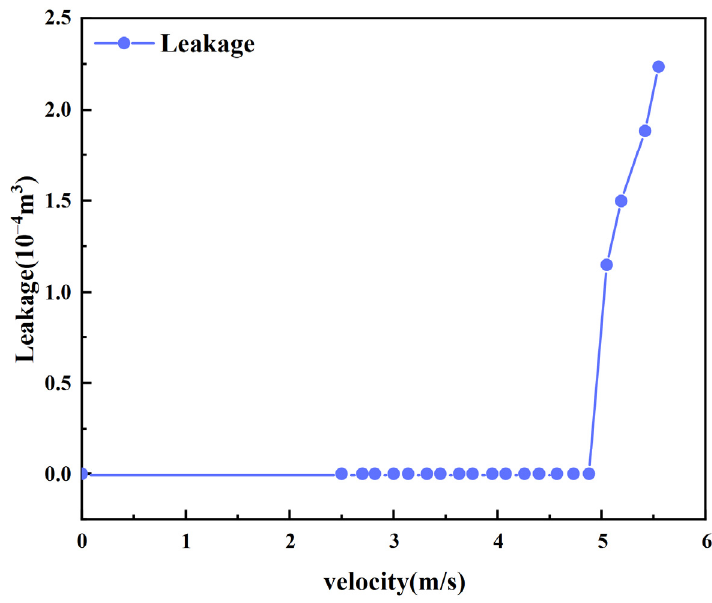
Figure 6. Relationship between velocity and leakage.